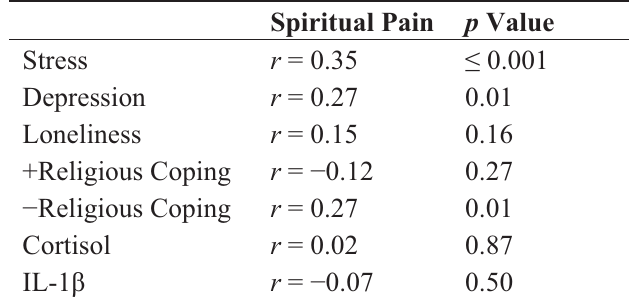
Table 3. Correlation coefficient for psychometric and biological data ( N =